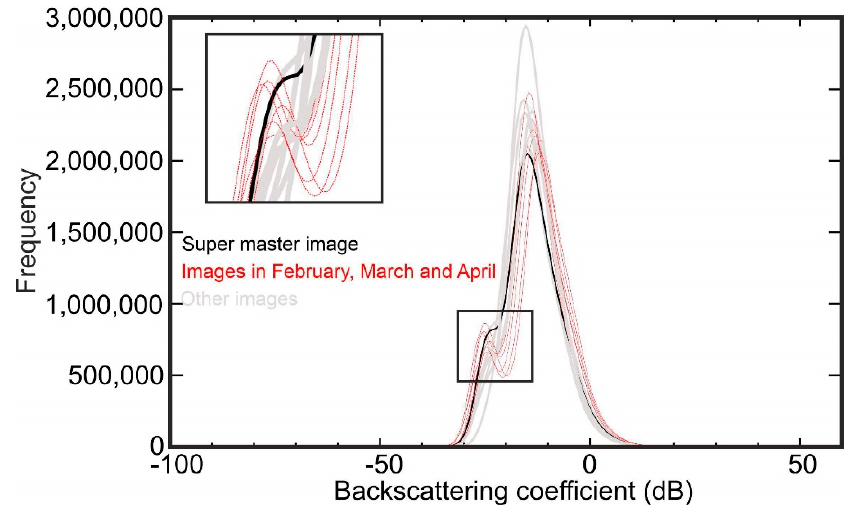
Figure 3. Histogram of PALSAR-2 images used in this study.